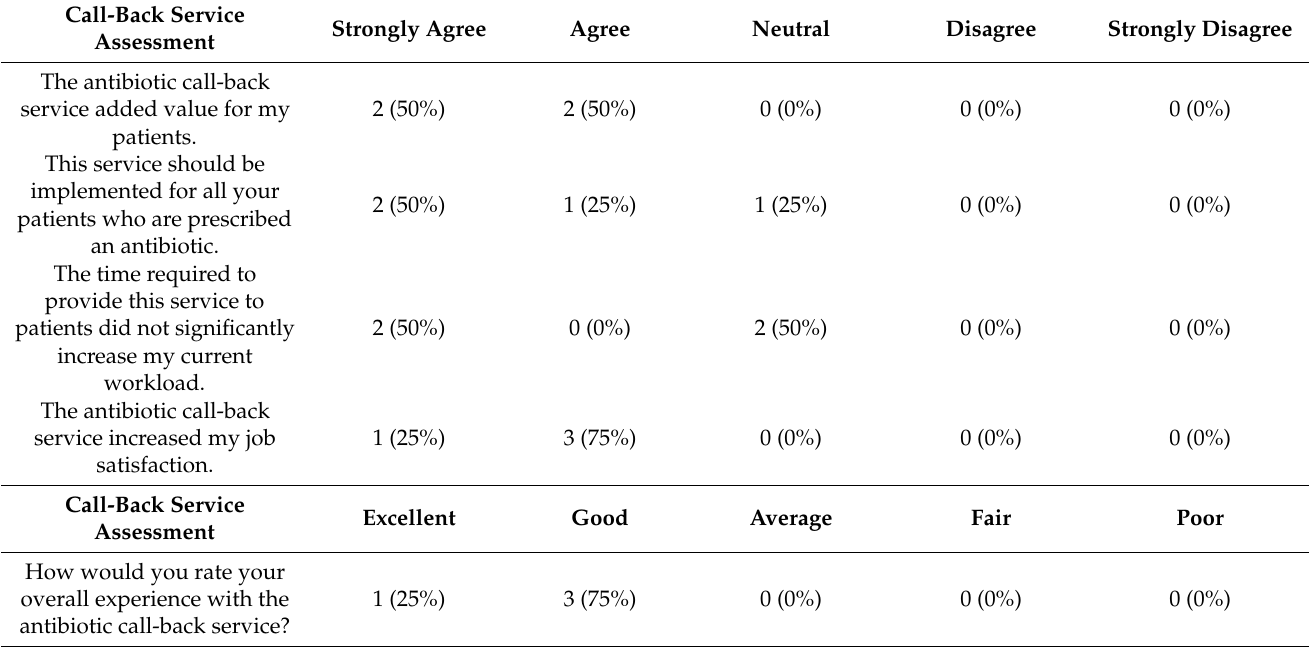
Table 2. Pharmacist Feedback with the Call-Back Service n =